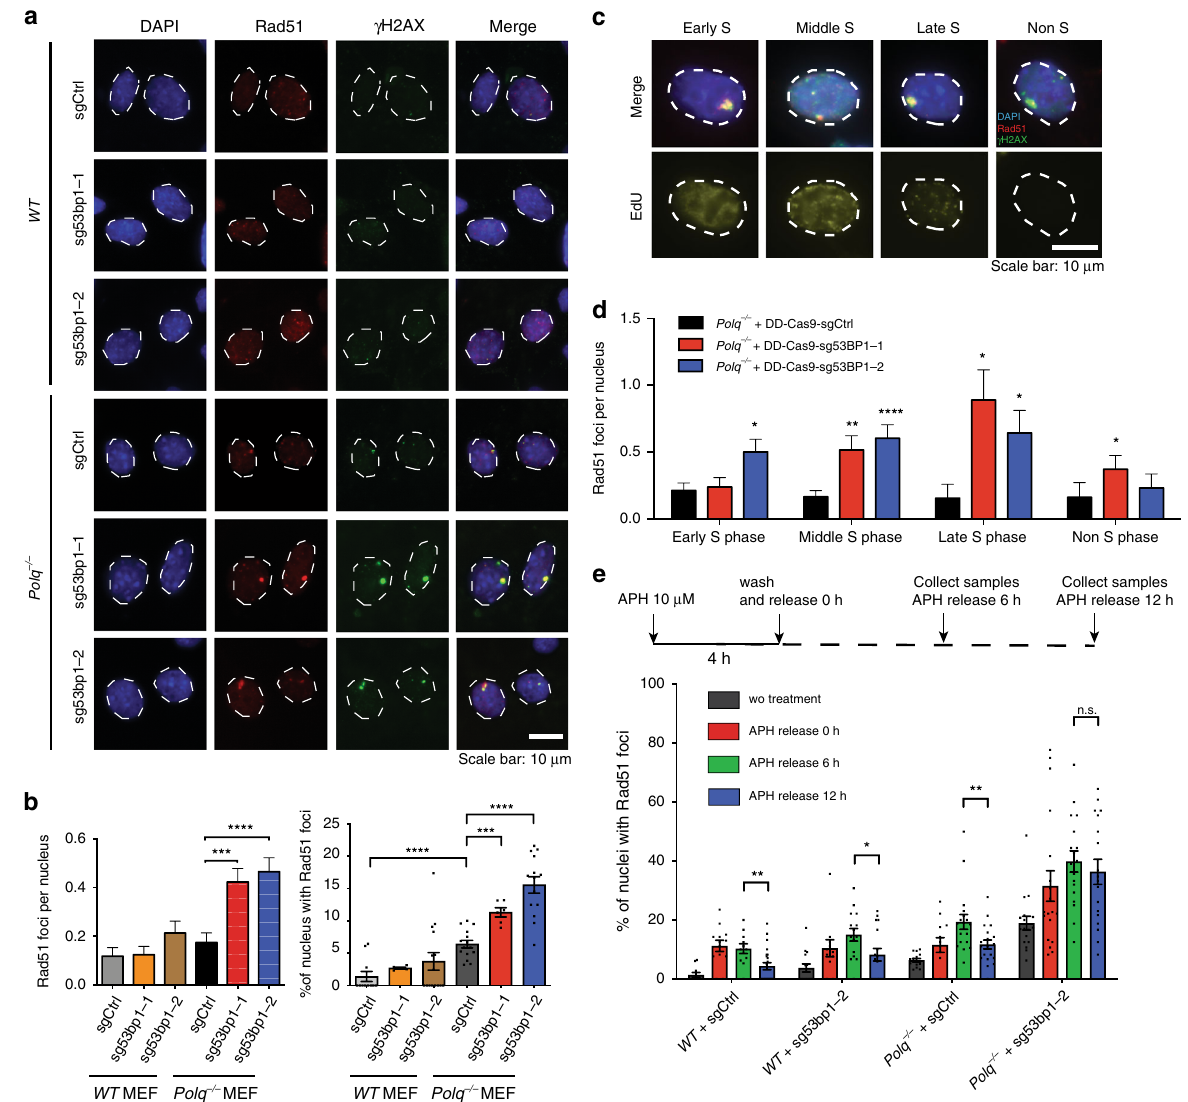
Fig. 3 Polq / 53bp1 double knockout cells accumulate non-productive HR intermediates in S phase. a Representative immuno fl uorescence (IF) staining of Rad51 (red) and γ H2AX (green) foci formation in cells with the indicated genotypes, 48 h after Shield1 treatment. ( n = 3 biologically independent experiments). b Quanti fi cation of large Rad51 foci per nucleus and percentage of nucleus with Rad51 foci. Data shown are mean ± SEM, and consistent across three independent biological replicates. *** p < 0.001; **** p < 0.0001 using a Mann – Whitney test. c Representative co-IF images for Rad51 (red), γ H2AX (green), and EdU (yellow,10 min EdU pulse) in Polq − / − + sg53BP1-2 MEFs to distinguish cell cycle stages as indicated. d Quanti fi cation of large Rad51 foci per nucleus strati fi ed by cell cycle stage. * p < 0.05; ** p < 0.01; **** p < 0.0001 by a Mann – Whitney test. e Cells were treated with 10 µ M Aphidicolin for 4 h followed by release for 0, 6, and 12 h, fi xed cells and stained cells with Rad51. Quanti fi cation of the percentage of nuclei with Rad51 foci was performed. Data shown are mean ± SEM, and consistent across two independent biological replicates. * p < 0.05; ** p < 0.01 using a Mann – Whitney